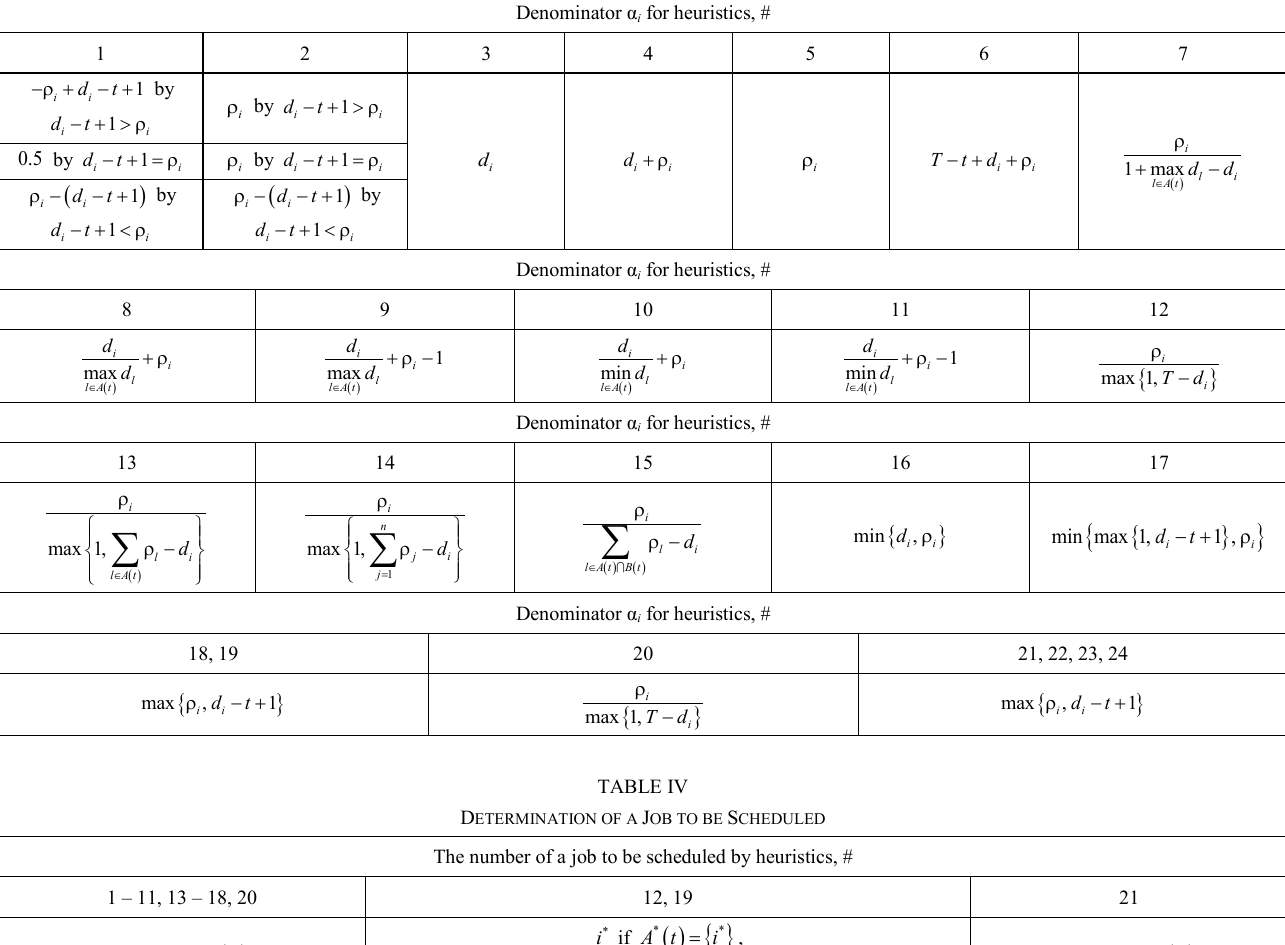
α IN THE D ECISIVE R ATIO FOR S ET (3) FOR 24 H EURISTICS D ENOMINATOR i Denominator α i for heuristics, #